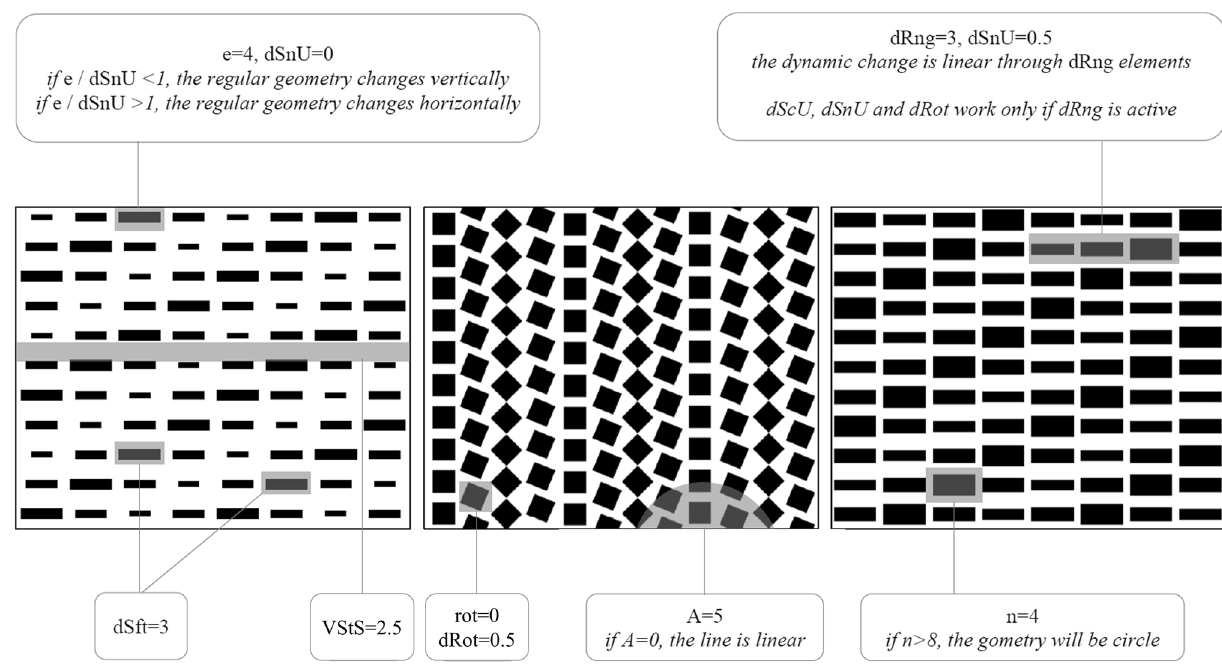
Fig. 7 Basic Geometry and Pattern Space